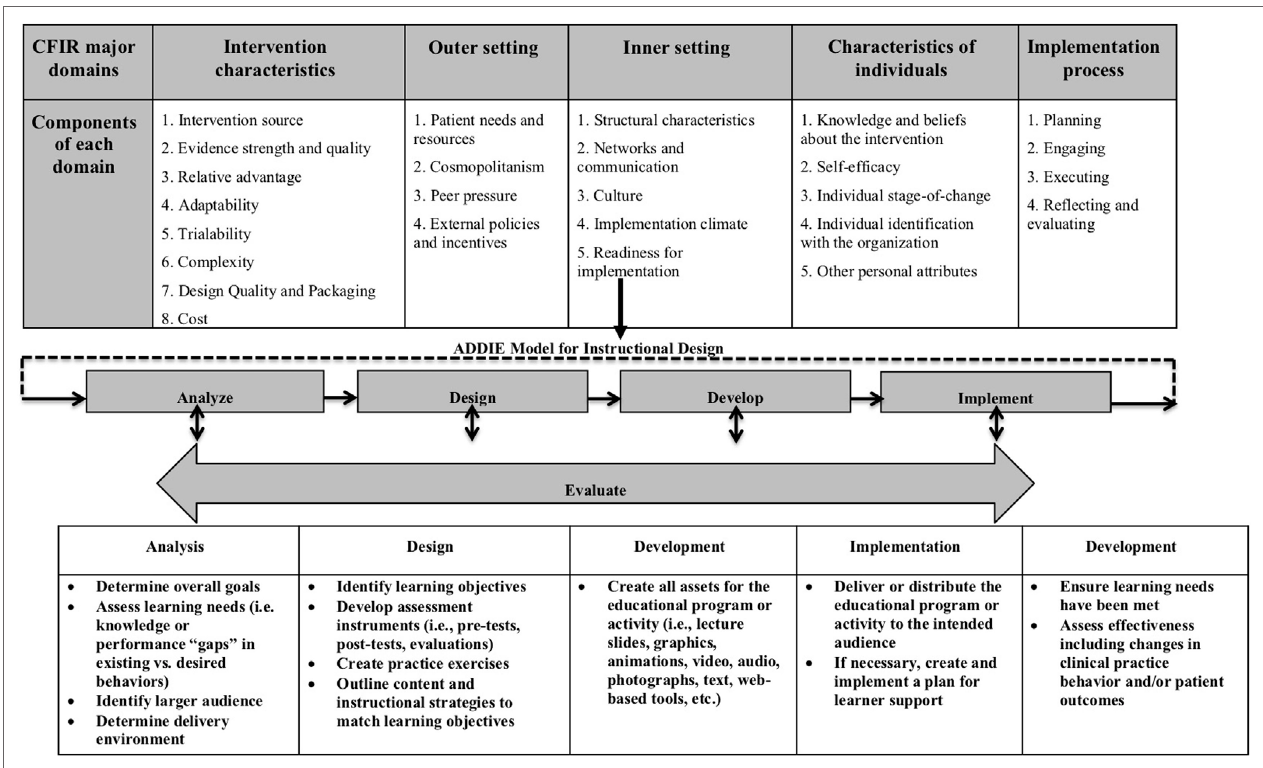
Figure 1 | Using an instructional design framework [Analyze, Design, Develop, Implement, and Evaluate (ADDIE)] as a systematic process to develop training in an implementation framework [Consolidated Framework for Implementation Research